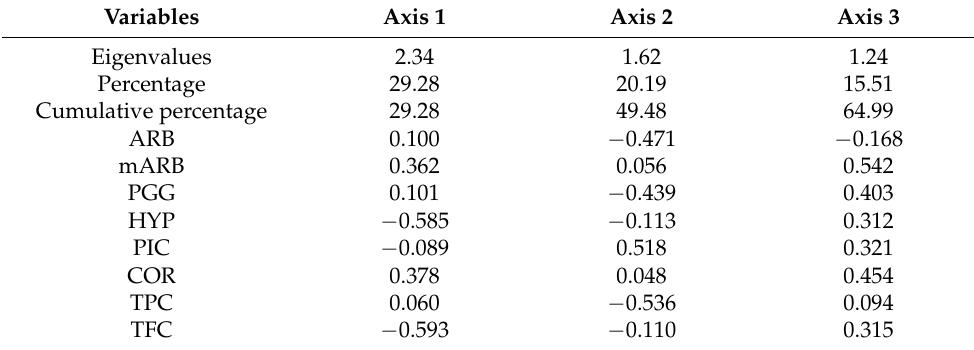
Figure 10. Total flavonoid content (mg QE g − 1 ) contents in leaf extracts from bearberry plants collected in heathland populations (orange) and in pine forest populations (green). For each site, data are mean and SD. The values designated by the different letters are significantly different (Tukey test, p < 0.05). Table 1. Results of PCA based on the chemical composition of bearberry leaf